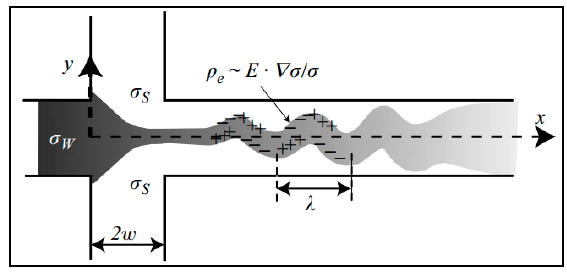
Figure 3. Schematic of the unstable flow in a cross-shaped microchannel with the characteristic D-shape and cross-sections of isotropic etching. σ s is the ionic conductivity of the sheath streams from top and bottom inlets. σ w is the ionic conductivity of the sample stream from the left inlet. Pe , E , λ , and w are charge density, electric field, nominal wavelength and half-width of channel, respectively. Reproduced with permission from